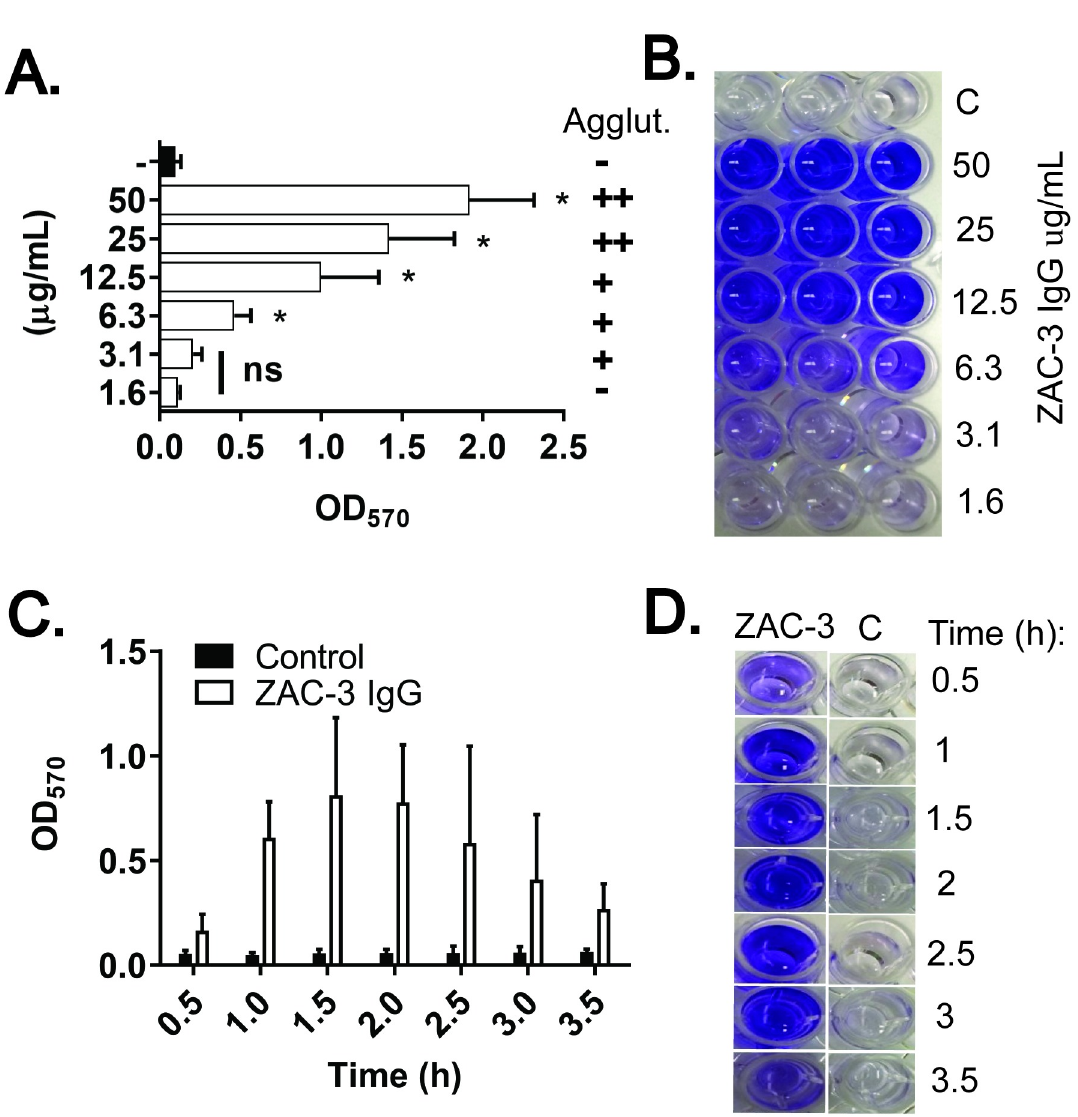
Fig 2. Dose and time dependent production of ECM by V . cholerae in response to ZAC-3 IgG treatment. (A) V . cholerae O395 was treated with indicated amounts of ZAC-3 IgG (1.6–50 μg/mL), or an isotype control (50 μg/mL) for 2.5 h before being assessed for ECM production using CV. Visible macroagglutination (Agglut.) is indicated on the right:—no agglutination; +, agglutination within 3 h; ++, agglutination within 2 h. Statistical significance was determined by one-way ANOVA followed by Tukey multiple comparison test: (cid:3) , P < 0.05; ns, not significant. (B) Representative image of CV staining for a single biological replicate (done in triplicate) from Panel A. C; control. (C) CV production as a function of time (hours) following treatment with ZAC-3 IgG (9 μg/mL) or an